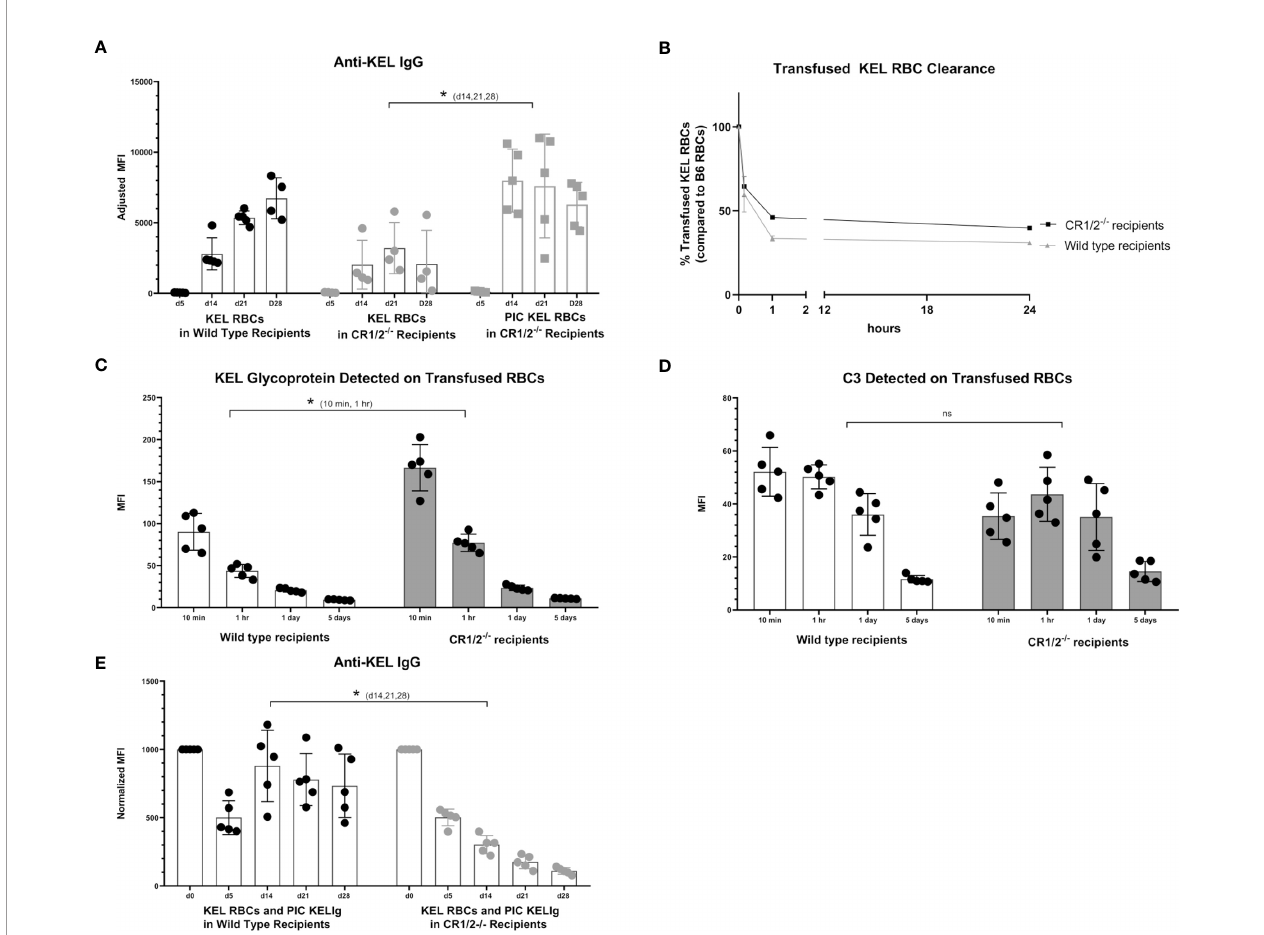
FIGURE 6 | CR1/2 are required for KELIg immunoprophylaxis failure in the setting of poly (I:C). (A) KEL RBCs were transfused into wild type recipients or recipients lacking CR1/2, in the presence or absence of poly (I:C). (B) RBCs were labeled with DiO and mixed with wild type RBCs labeled with DiI; this mixture was transfused into wild type or CR1/2 -/- recipients that had been infused with KELIg and treated with poly (I:C). Recovered DiO positive KEL RBCs were evaluated for (C) KEL glycoprotein expression, and (D) bound complement C3. (E) Wild type or CR1/2 -/- recipients were infused with KELIg and transfused the following day in the absence or presence of poly (I:C), with anti-KEL responses evaluated longitudinally. *p < 0.05 for d14, 21 and 28 of (A) between CR1/2 -/- mice treated with or without poly (I:C); p < 0.05 for 10 min and 1-hour timepoints in (C) ; p < 0.05 for d14, 21, and 28 in (E) . These data are representative of 2-3 independent experiments with 3 mice/group/experiment; error bars indicate standard deviation between mice. ns, not signi fi